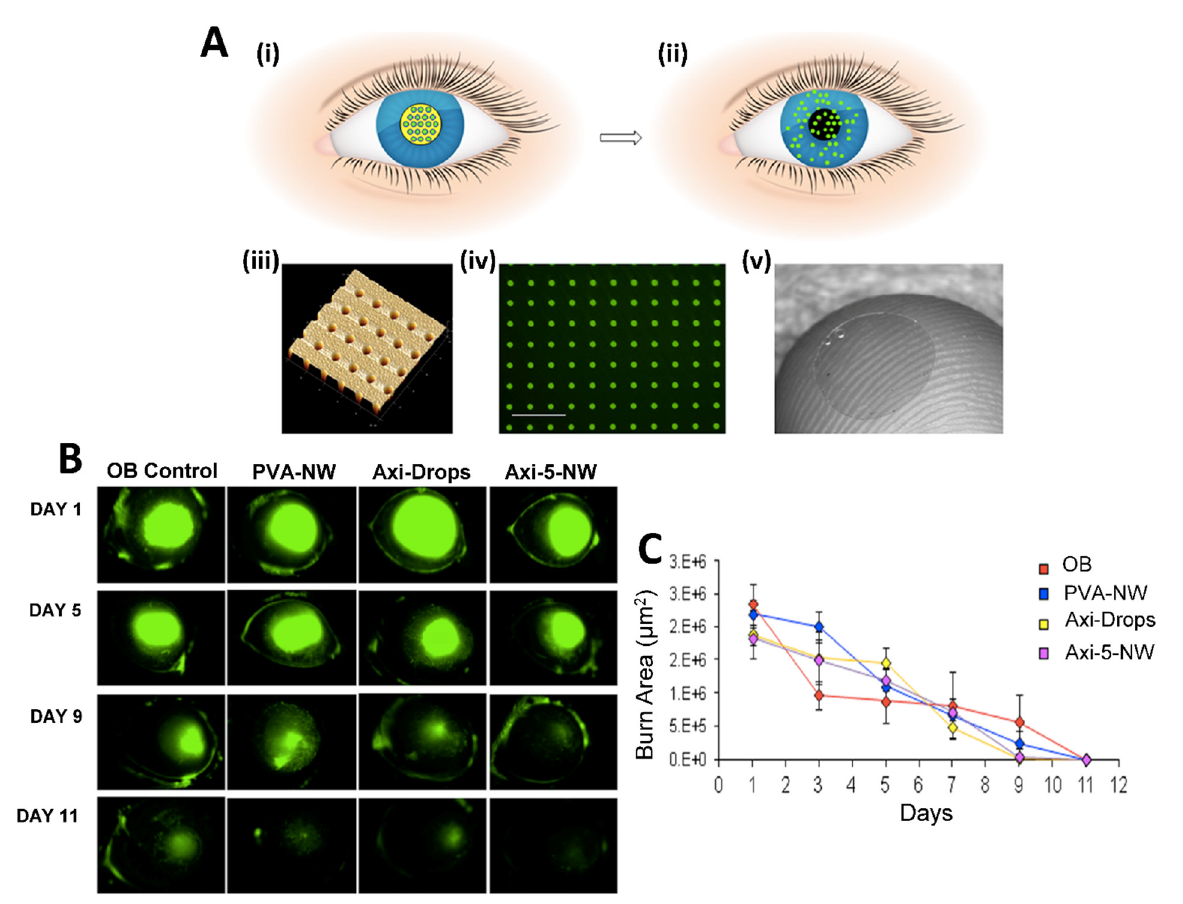
Figure 6. ( A ) (i) Schematic of the nanowafer being implanted on the cornea. (ii) Drug diffusion into the corneal tissue. (iii) Atomic force microscope image of a nanowafer displaying an array of 500 nm diameter nanoreservoirs. (iv) Fluorescence micrograph of a drug (doxycycline) loaded nanowafer (scale bar 5 µ m). (v) Nanowafer on a fingertip. ( B ) Fluorescence images of mouse cornea to which was applied axitinib loaded nanowafers. ( C ) Graphic demonstrating corneal surface healing period. Reprinted with permission from [154] under Editors’ Choice Usage Agreement, American Chemical